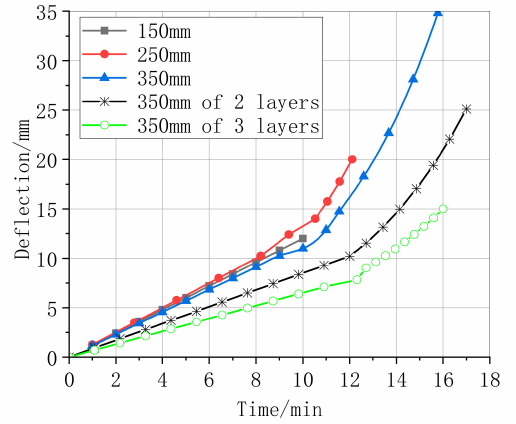
Figure 7. Deflection of the CFRP